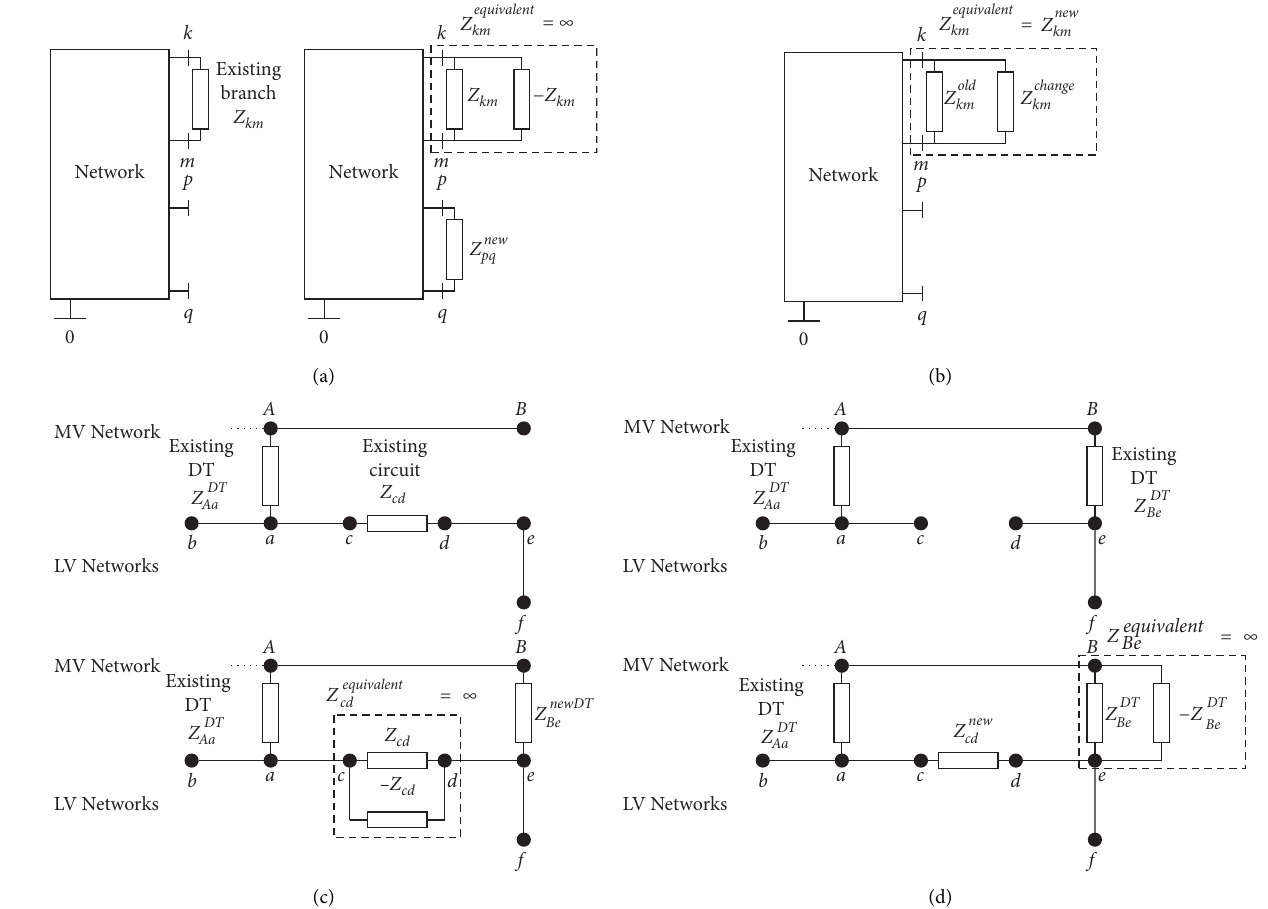
Figure 2: Zbus modification due to neighborhood criteria. (a) Branch exchange. (b) Upgrading or degrading capacity. (c) DT installation. (d) DT